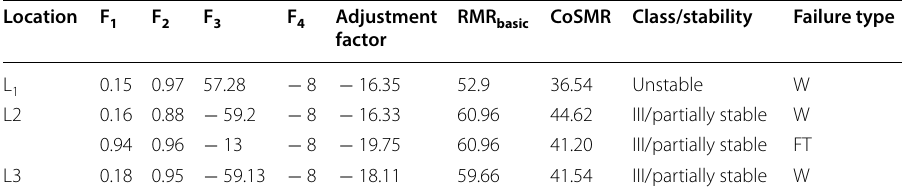
Table 5 Correction factors for the estimation of CoSMR [47] Location F 1